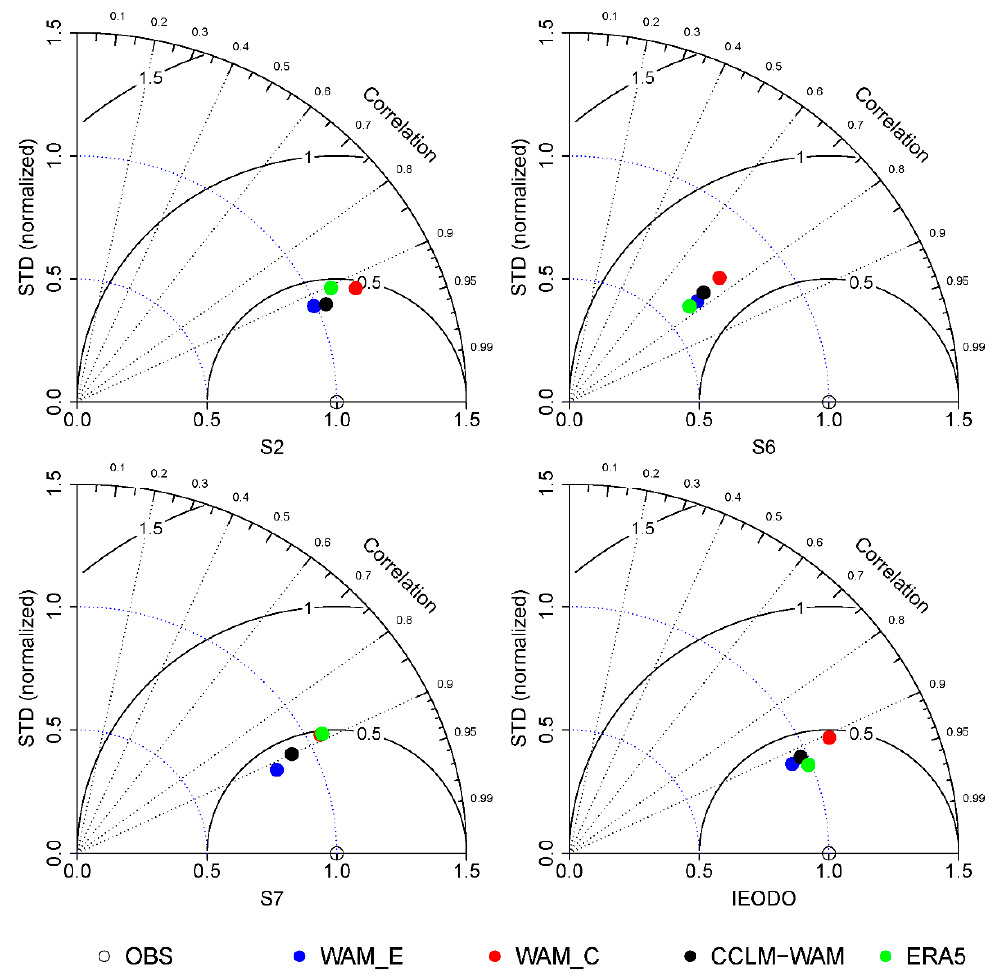
Figure 5. The same as Figure 2 but for significant wave height at different stations. Table 4. Bias (m) and mean absolute error (MAE, m) between simulated and observed significant wave height at four stations. 95% confidence interval of bias and MAE are listed. Italic value means that it does not pass the significance test at a level of 0.05. Bold represents the best skill in each column.